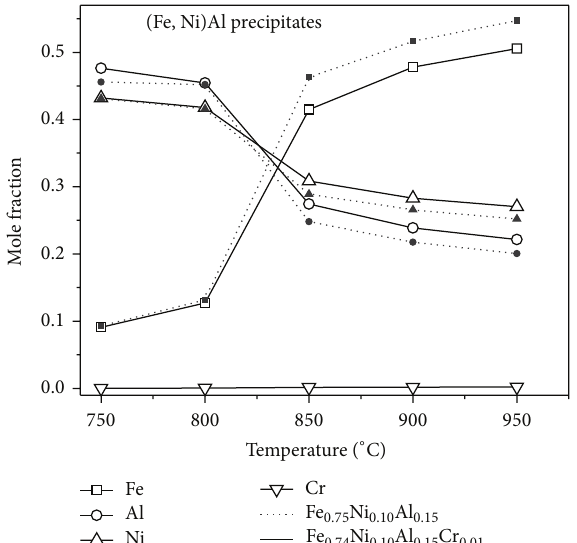
Figure 6: Calculated fraction mole of alloying elements in the 𝛽 󸀠 precipitates against aging temperature for the Fe 0.75 Ni 0.10 Al 0.15 and Fe 0.74 Ni 0.10 Al 0.15 Cr 0.01